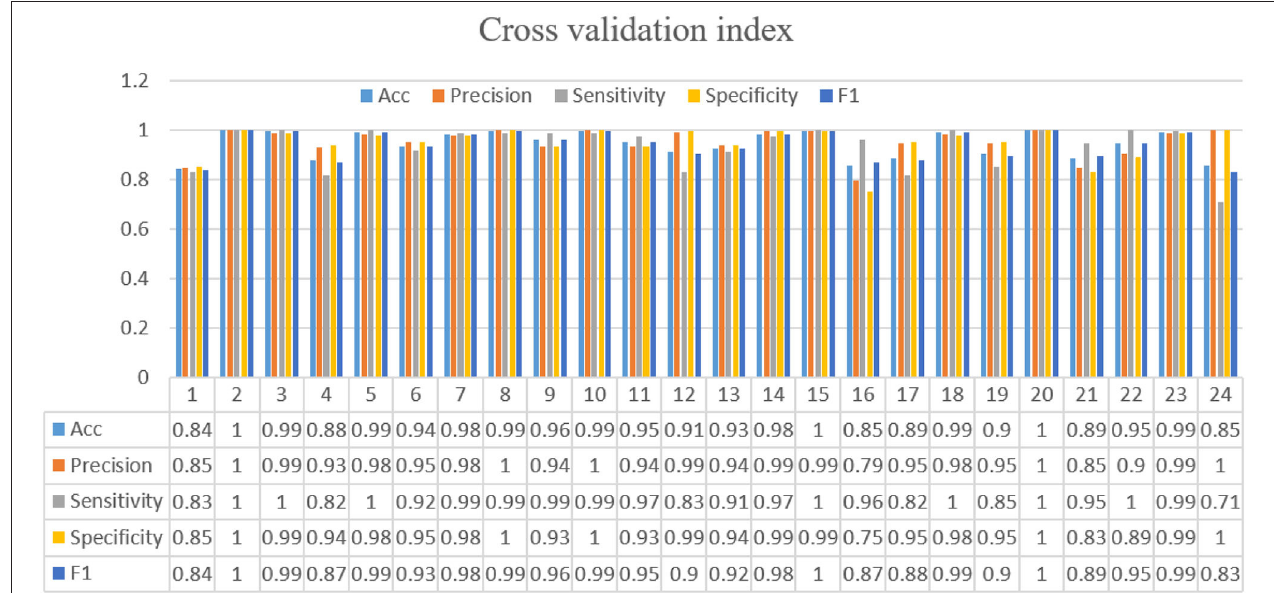
FIGURE 8 | Twenty-four-fold cross-validation results including accuracy, precision, sensitivity, specificity, and F1 evaluation indicators.